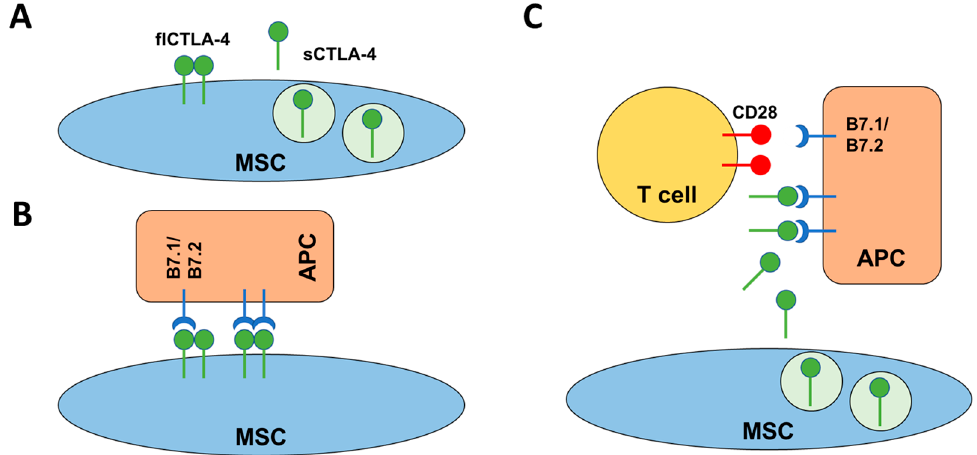
Figure 4. Schematic representation of the mode of action of CTLA-4 mediated inhibition of, e.g., T cell activation. ( A ) MSCs are able to express two different isoforms of CTLA-4. The flCTLA-4 is a membrane-bound dimer while sCTLA-4 is a secreted monomeric isoform of CTLA-4. ( B ) Under normoxic conditions, flCTLA-4 may mediate cell contact-dependent inhibition of T cell responses by direct interaction with B7.1/B7.2 on the surface of APCs. ( C ) Under hypoxic conditions, MSC may switch to a cell contact-independent mechanism where sCTLA-4 is able to bind B7.1/B7.2 on APCs, thereby blocking CD28 mediated co-stimulation of T cells.